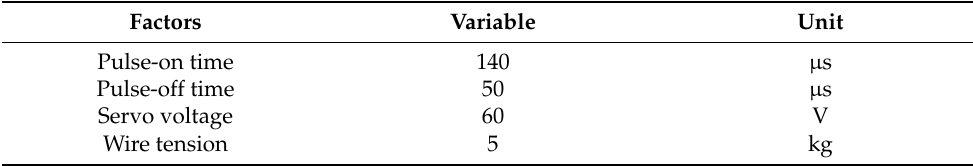
Table 7. Identification of optimum